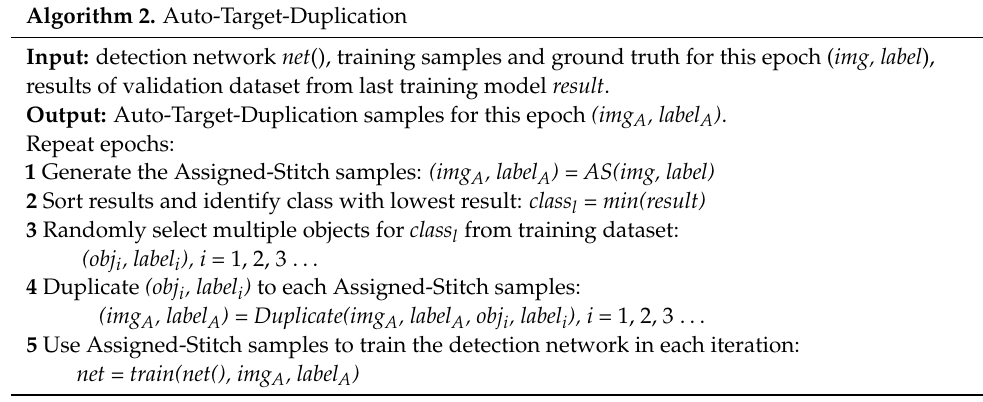
Figure 9. Auto-Target-Duplication module. Algorithm 2.